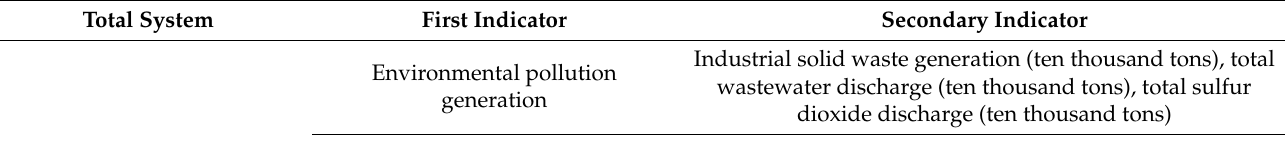
Table 1. Index system for EE, TI, and